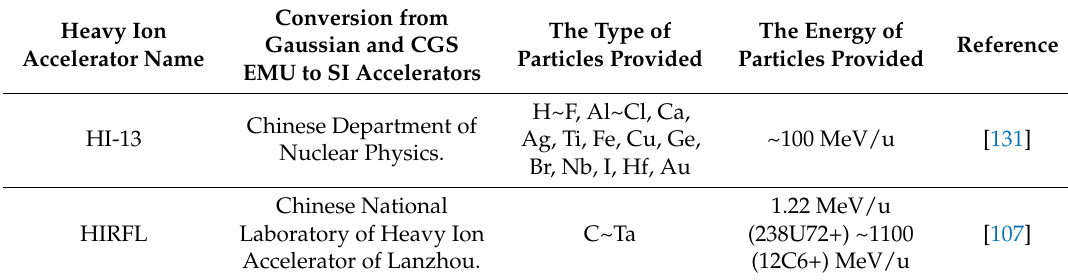
Table 8. Existing heavy ion